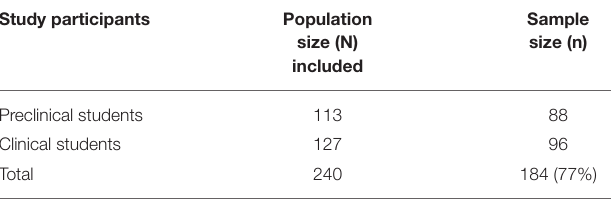
TABLE 1 | Sample size determination for study participants.